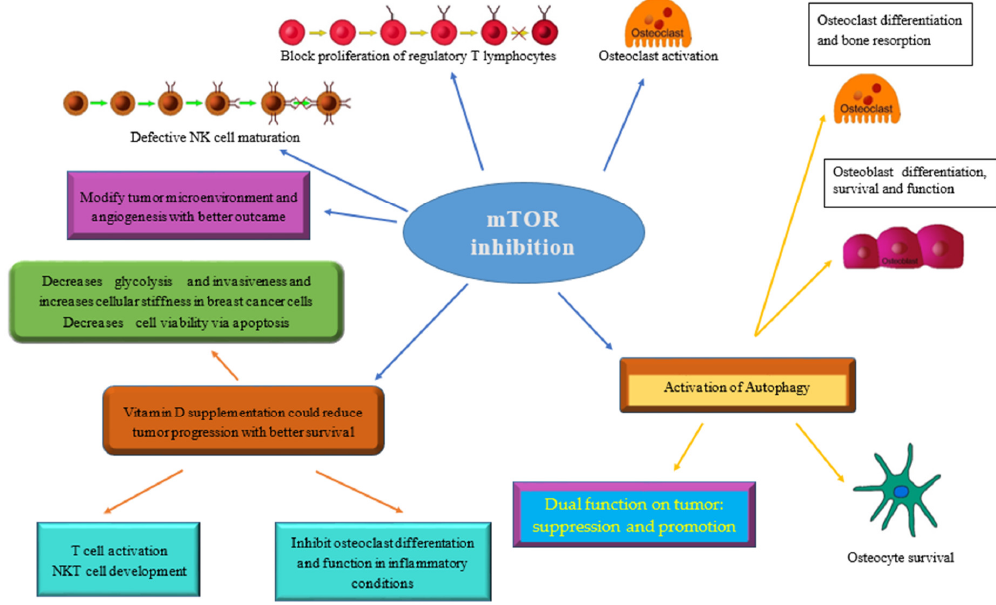
Figure 3. The main consequences of mTOR inhibition on tumor, bone, and the immune system are summarized along with how vitamin D supplementation can modulate its effects and contribute to achieving a better therapeutic